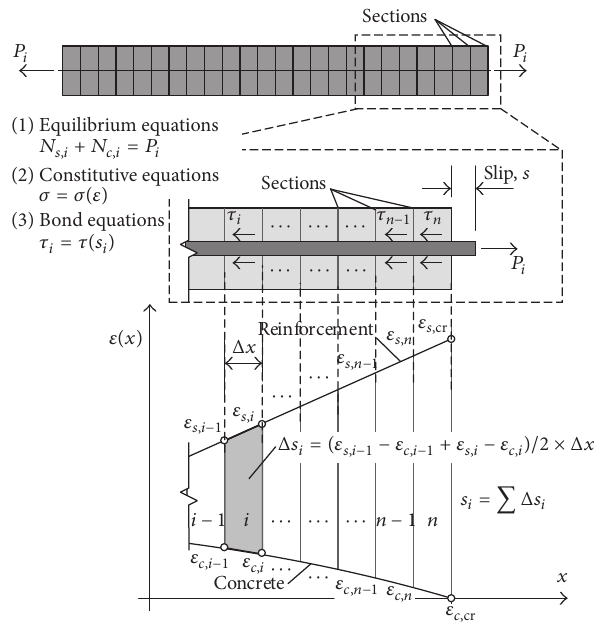
Figure 7: Stress transfer